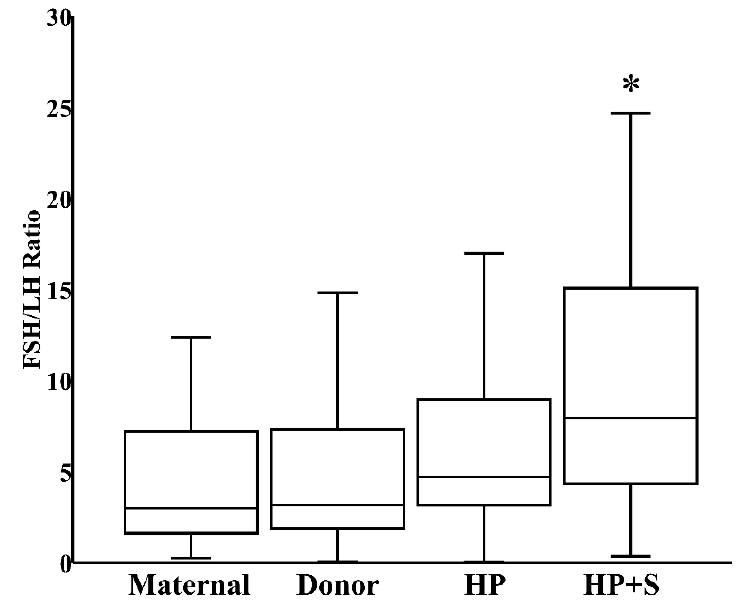
Figure 4. FSH:LH ratio in fresh maternal milk ( N = 27), fresh donor milk ( N = 30), pasteurized donor milk (HP, N = 30), and pasteurized donor milk after refrigerated storage (HP + S, N = 30). * p < 0.05 versus fresh donor milk or HoP donor milk.